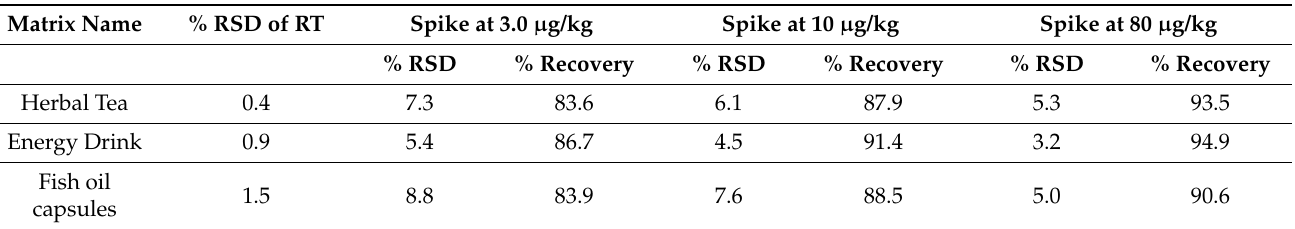
Table 8. Accuracy and Precision on day 1.